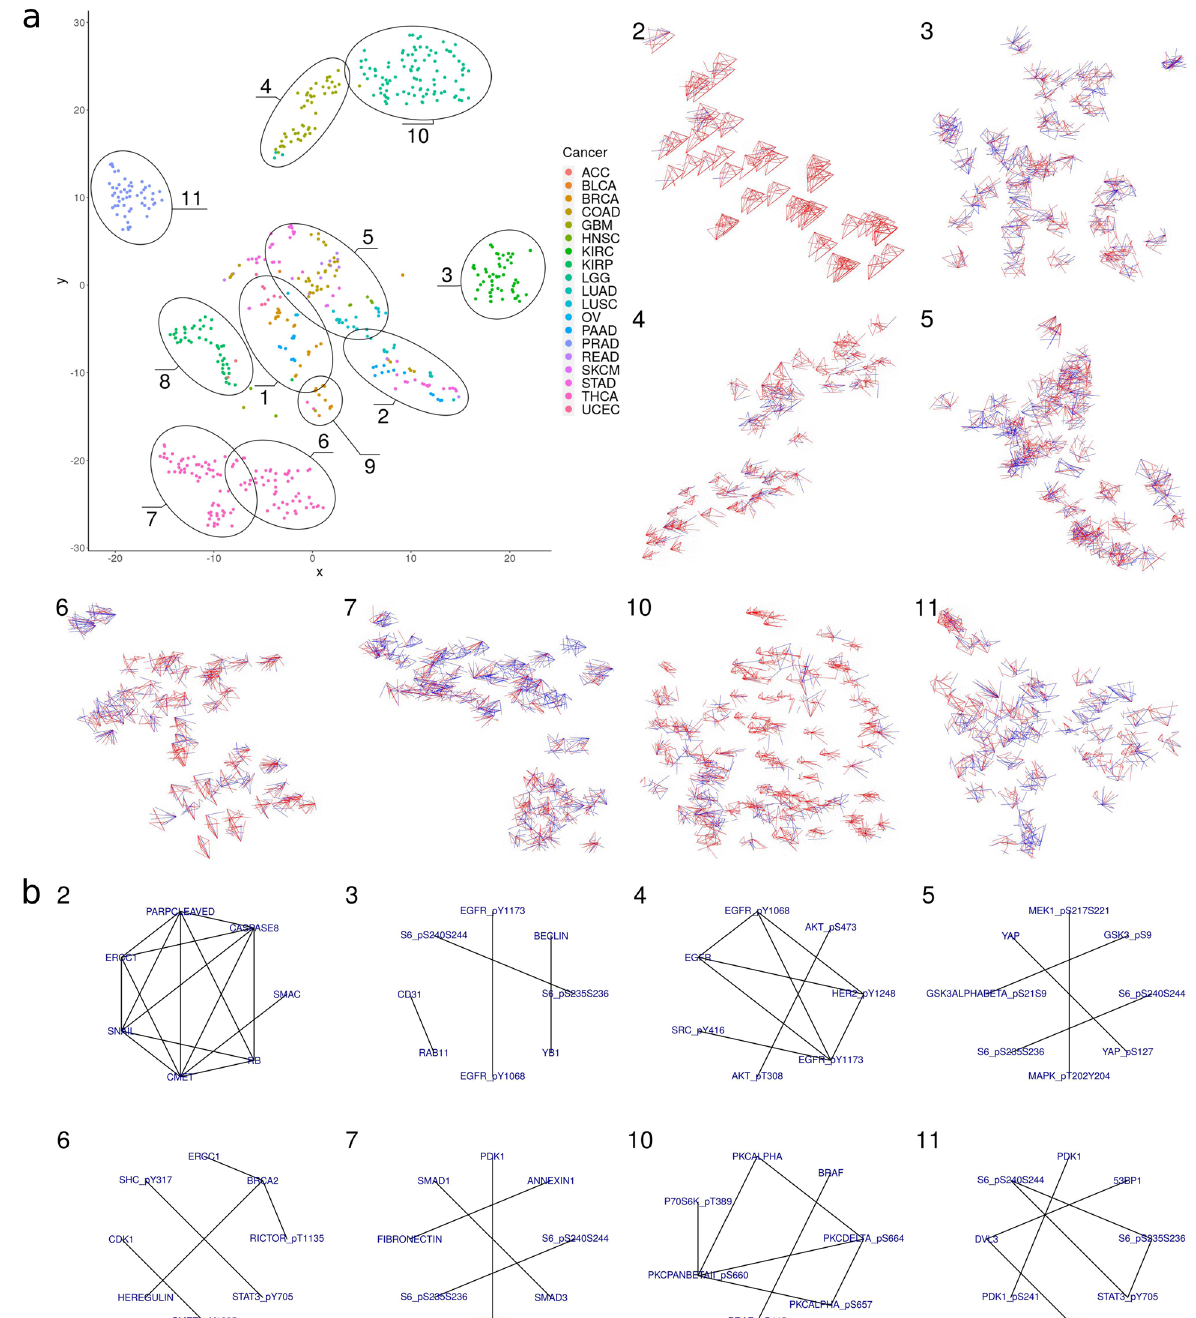
Fig. 2 Interaction network prediction for individual patients. a t-SNE of tumors according to their predicted protein interactions. Every dot refers to one tumor sample. Multiple groups of samples can be separated, and in many cases, tumors of the same cancer type fall into the same cluster. Cancer types that build distinct groups are thyroid cancer (C6, C7), clear cell renal carcinoma (C3), and prostate adenocarcinoma (C11). Samples of the brain cancers glioblastoma (C4) and low-grade glioma (C10) are embedded in close proximity, but can still be separated from each other. The subplots in ( a ) illustrate the individual interaction networks for the eight largest clusters from the t-SNE analysis (additional clusters can be found in Supplementary Figs. 3 and 4). The interaction graphs are arranged according to their computed position in the t-SNE analysis to show differences in networks within one cluster. For illustration, only the strongest 0.1% of raw LRP scores are displayed (red: LRP r > 0, blue: LRP r < 0). Samples within the same cluster had similar strongest interactions and some clusters are tumor type speci fi c (e.g., C3, C6, C7, C11), whereas others contain different tumor types (e.g., C2, C5). The fi nding that highly similar predicted network features can be found across certain tumor types is particularly clearly visible for cluster 2. b Median interaction network for each of the clusters in ( a ). Interactions with EGFR play an important role in cluster 4 (glioblastoma), while Beclin and YB1 are important in cluster 3 (renal clear cell carcinoma). The group of homogeneous networks in cluster 2 shows the strongest interactions between cMET, ERCC1, Caspase-8, Snail, PARP, Rb, and